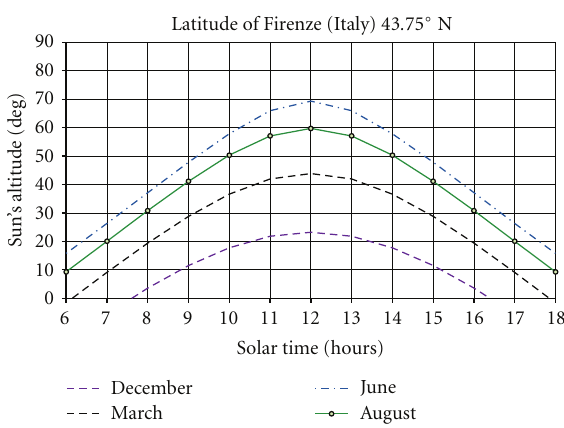
Figure 1: Altitude of sun over the horizon for Firenze